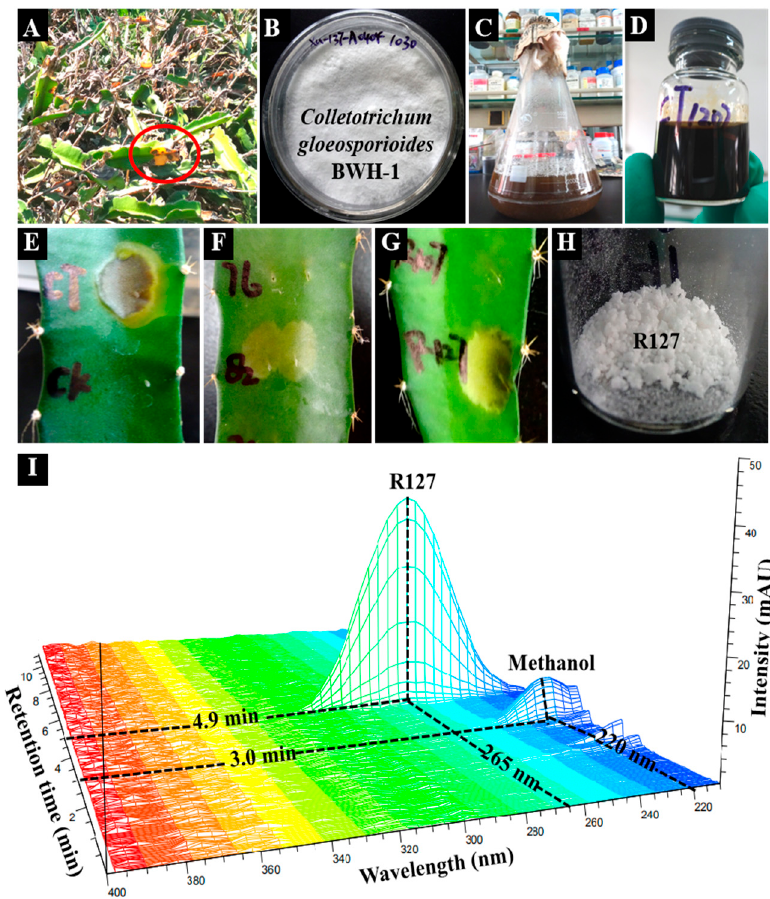
Figure 1. Bioactivity-guided isolation of the major phytotoxin produced by Colletotrichum gloeosporioides BWH-1. ( A ) Anthracnose disease of Bawanghua ( Hylocereus undatus ); ( B ) the pathogenic fungus